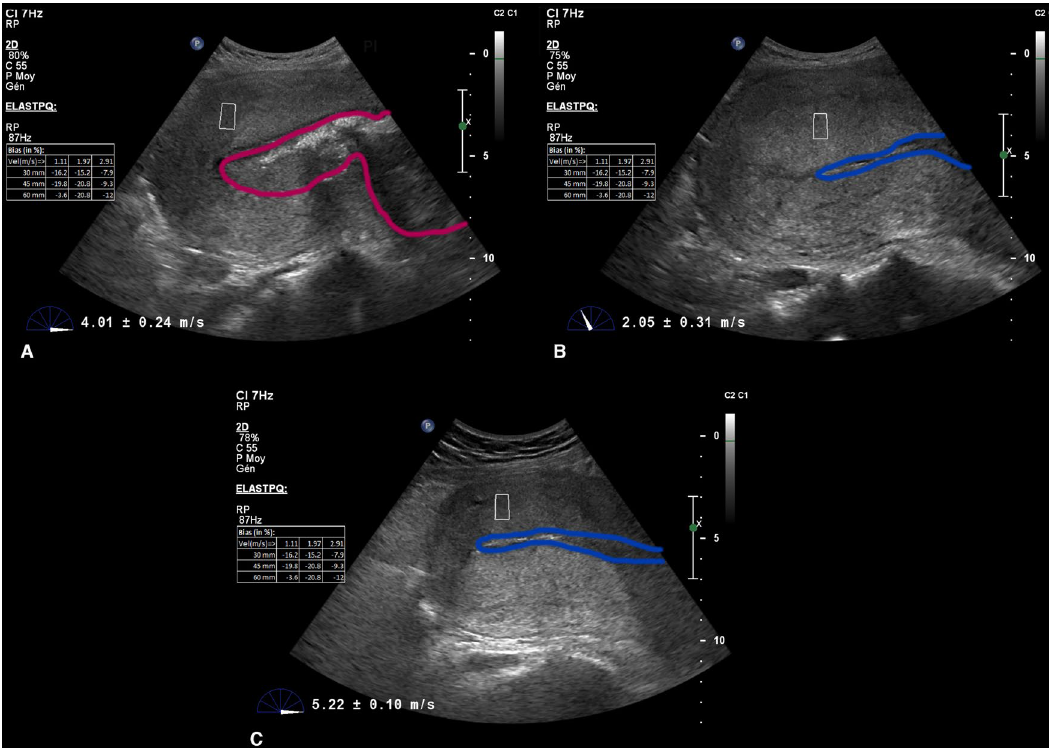
Figure 1. Ultrasound shear wave elastography images. Shear wave measurement at the different time points. ( A ) Before placental expulsion. ( B ) Immediately after placental expulsion. ( C ) 30 min after placental expulsion. Pink outline illustrates the placenta. Blue outline illustrates the uterine